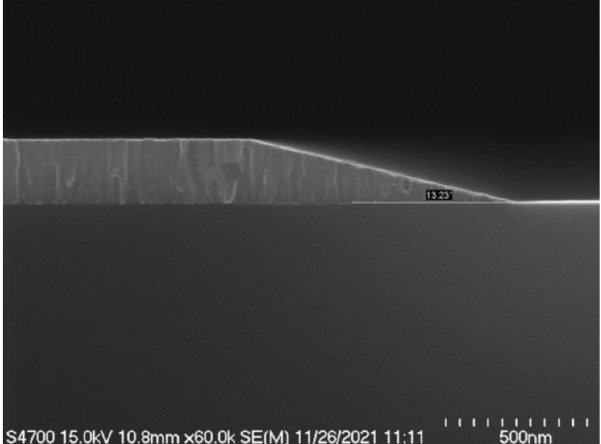
Figure 5. Small-angle diagram after etching the bottom